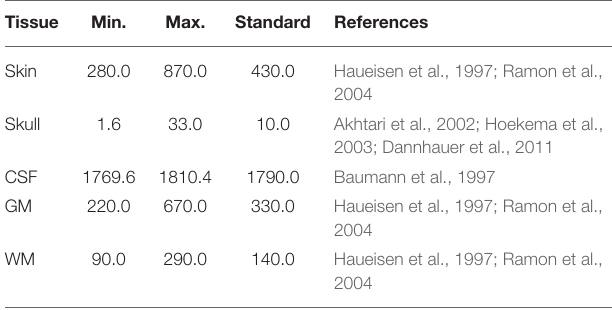
TABLE 1 | Tissue conductivity intervals